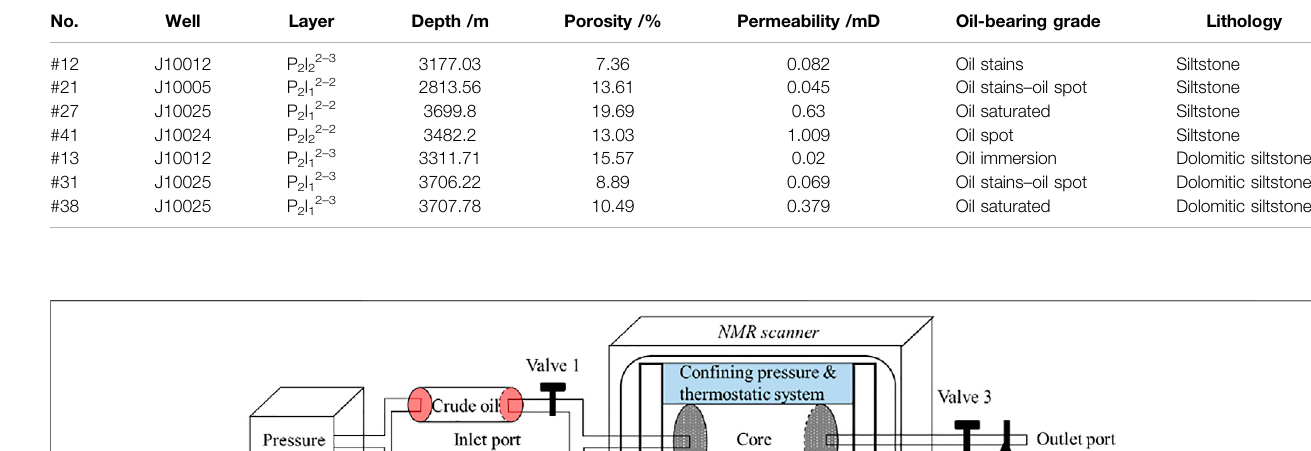
TABLE 1 | Basic information of experimental samples.